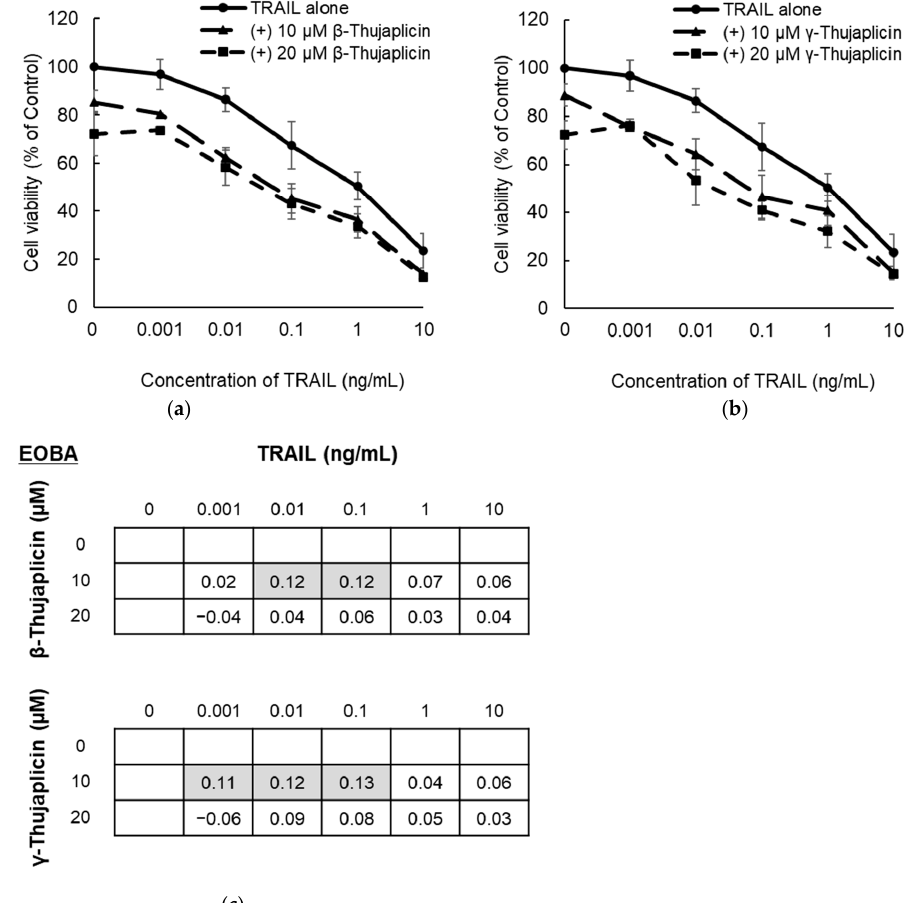
Figure 3. Enhancement of the antiproliferative effect of TRAIL on NCI-H460 cells by combination treatments with β - or γ - thujaplicin. NCI-H460 cells were cotreated with the indicated concentrations of TRAIL and β -thujaplicin ( a ) or γ -thu- japlicin ( b ) for 24 h. Cell viability (% of control) was measured using a WST assay and EOBA scores were calculated ( c ). Data are the averages of three independent experiments and error bars show standard